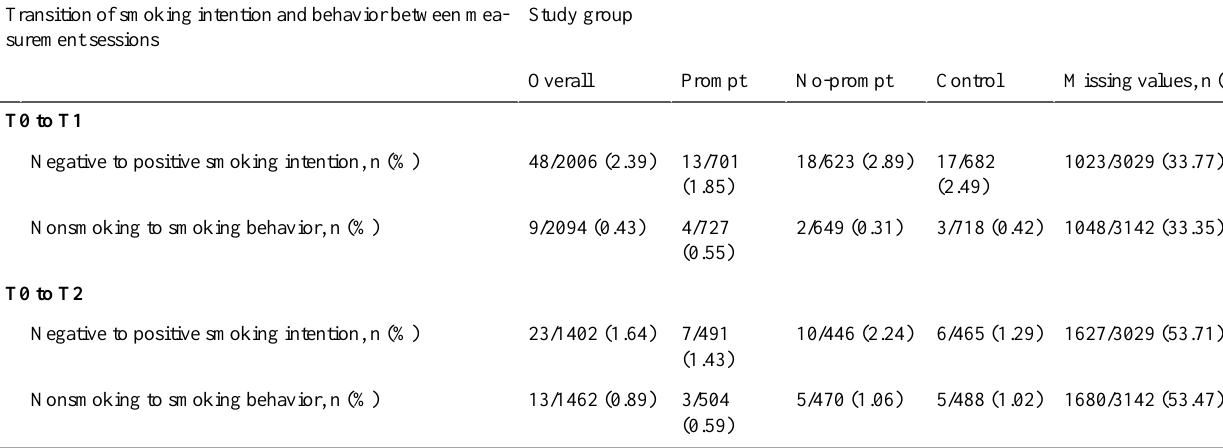
Table 2. Transition of intention to start smoking and smoking behavior between T0 and T1, and between T0 and T2.